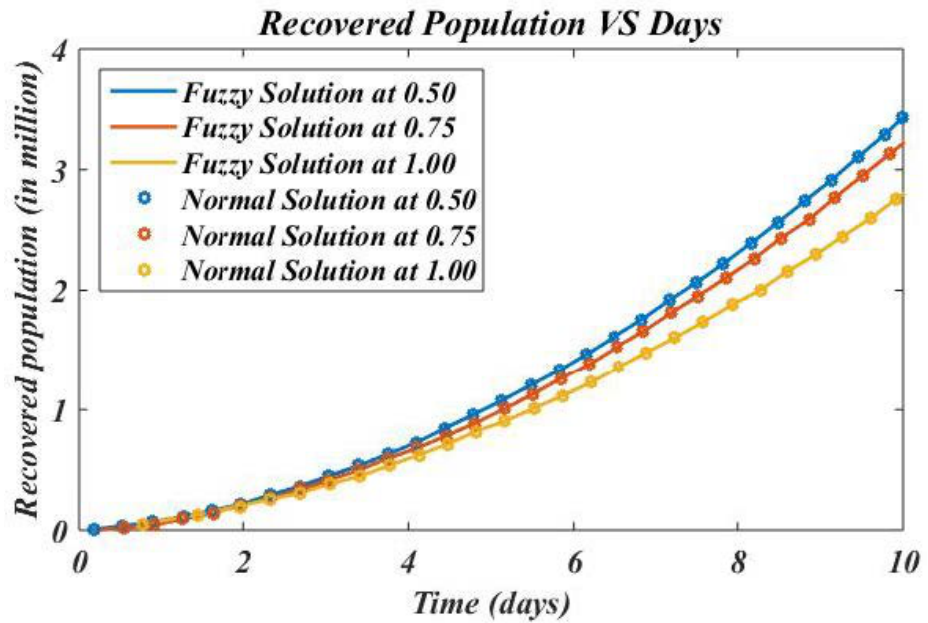
Figure 4. Illustration of approximate fuzzy and normal recovered compartment solutions for three terms at given uncertainty levels ϑ ∈ [ 1,2 ] versus fractional